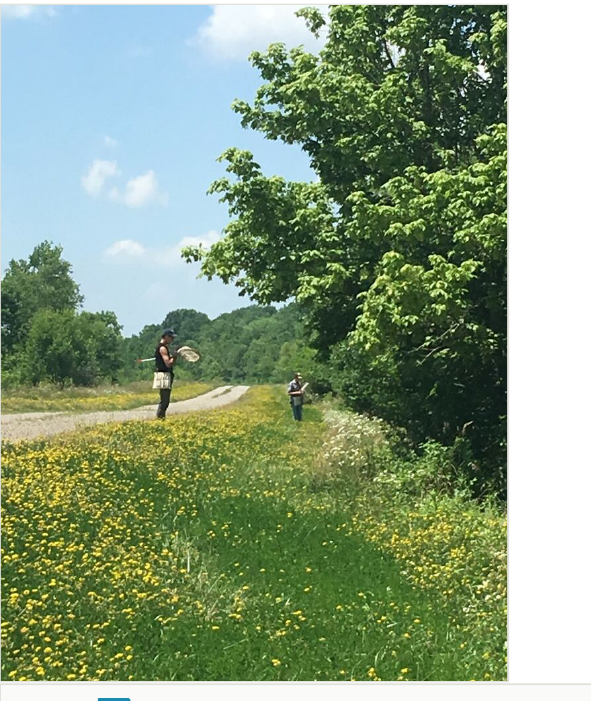
Figure 3. Typical grassland-forest habitat matrix of Sparta Training Area. Lotus corniculatus (Fabaceae) in bloom. JLC and Daniel Crosby pictured hand-netting floral visitors. Photo credits Carmen